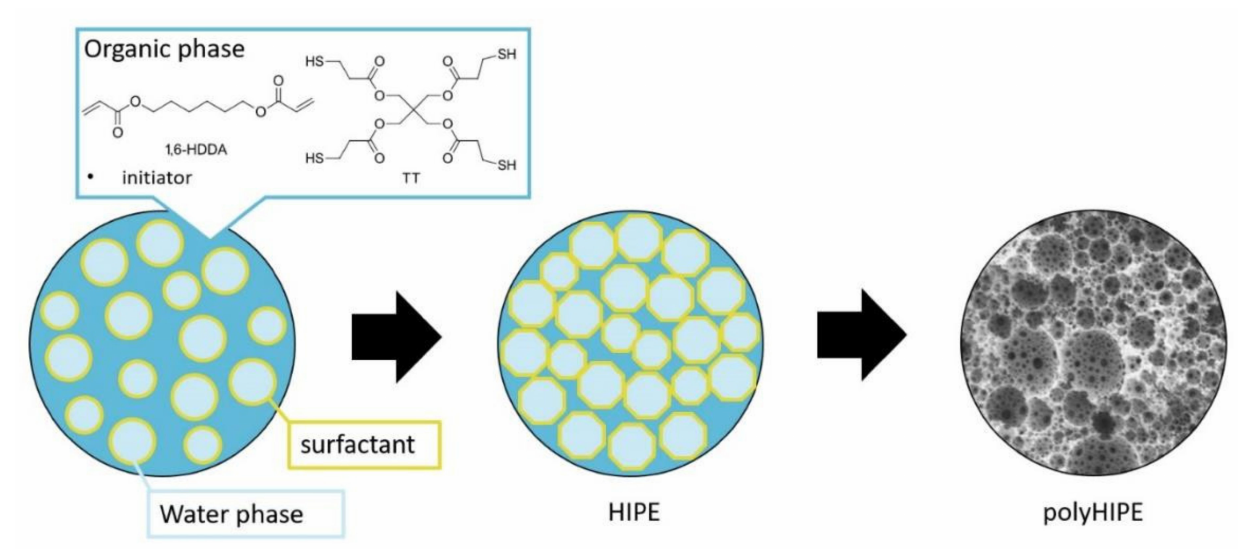
Figure 1. General scheme of porosity templating via high internal phase